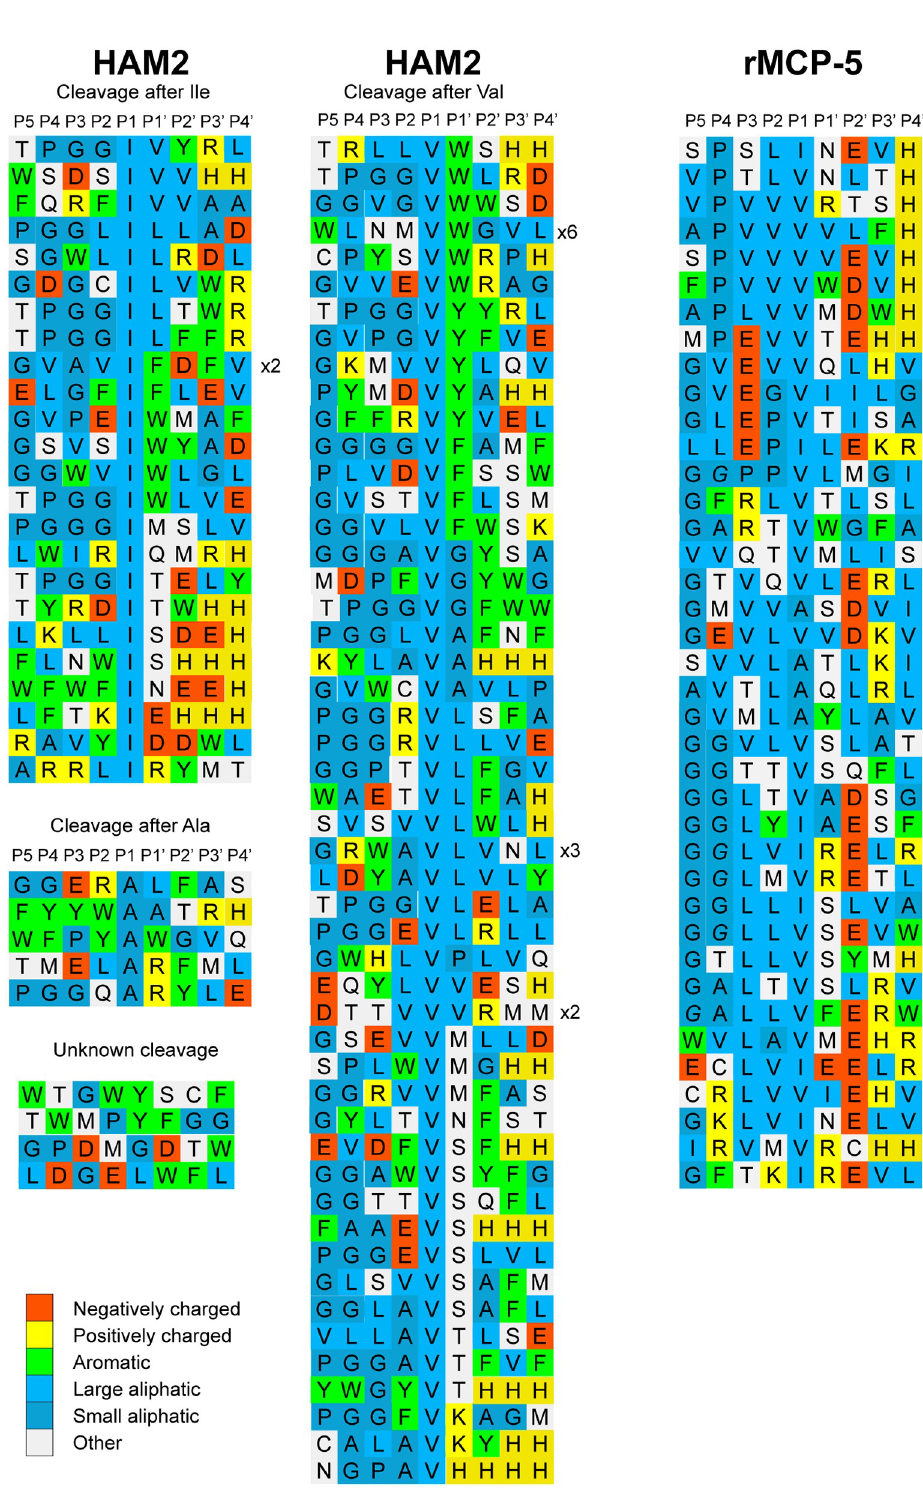
Fig 6. Phage displayed nonamers susceptible to cleavage by HAM2 after eight biopannings. After the last selection step, phages released by proteolytic cleavage of the three proteases were isolated and the sequences encoding the nonamers were determined. The general sequence of the T7 phage capsid proteins are PGG(X) 9 HHHHHH, where (X) 9 indicates the randomized nonamers. The protein sequences were aligned into a P5-P4´ consensus, where cleavage occurs between positions P1 and P1´. If the sequence was found more than once this is indicated by the